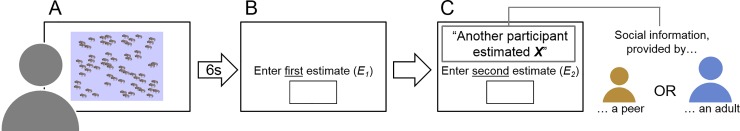
Experimental task.a, Participants observed an image showing a group of animals for 6 seconds and had to estimate the number of animals. b, Once the image had disappeared, participants entered their first estimate (E1). c, Then, they observed social information (X; the estimate of another participant who completed the task before without social information) and entered their second estimate (E2). This procedure was repeated for five rounds, in each of two experimental conditions, in which social information was provided by either a peer student (yellow) or an adult (blue). In each round, social information use was calculated as s = (E2 –E1) / (X–E1), and for each experimental condition, each participant’s social information use was characterized as the average value of s across the five rounds. Participants did not receive any feedback about their accuracy (nor the accuracy of the social information) between trials.